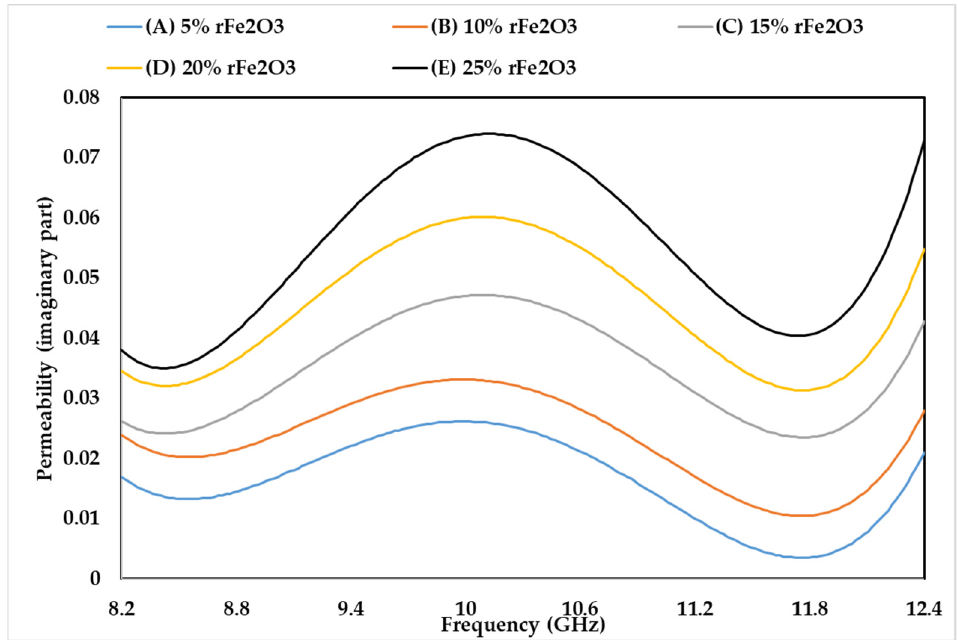
Figure 15. Variation in permeability (imaginary part) of rFe 2 O 3 –PTFE nanocomposites using rectan- gular waveguide.